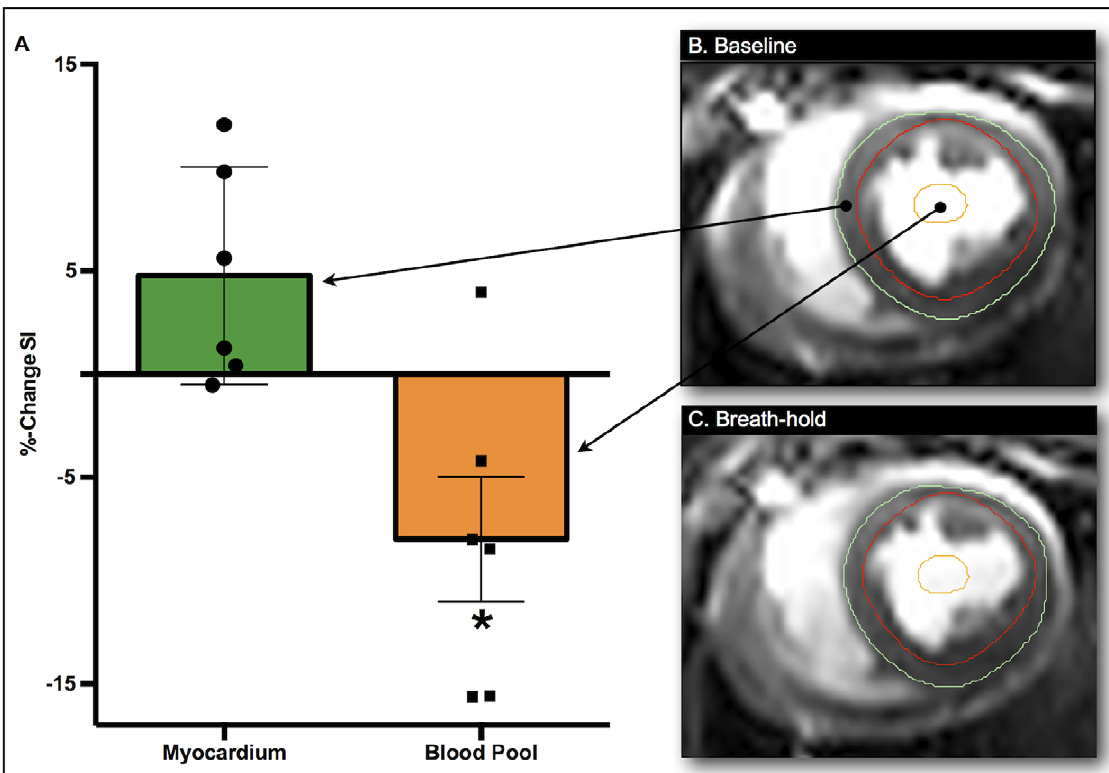
Figure 2. Change in arterial blood pool and myocardial tissue oxygenation during a 60 seconds breath-hold. Phase 11 of the cardiac cycle representing end-systole is presented for both the image from baseline ( B ) and the end of the breath-hold ( C ). The analyzed myocardial region is outlined on the BOLD-CMR image by the endocardial (red) and epicardial (green) contours resulting in a trend toward a mean SI increase ( + 4.8%; p =0.077, n=6) ( A ). The orange contour depicts a region of interest in the blood pool, with a significant mean SI decrease (-8.0%; p =0.047).